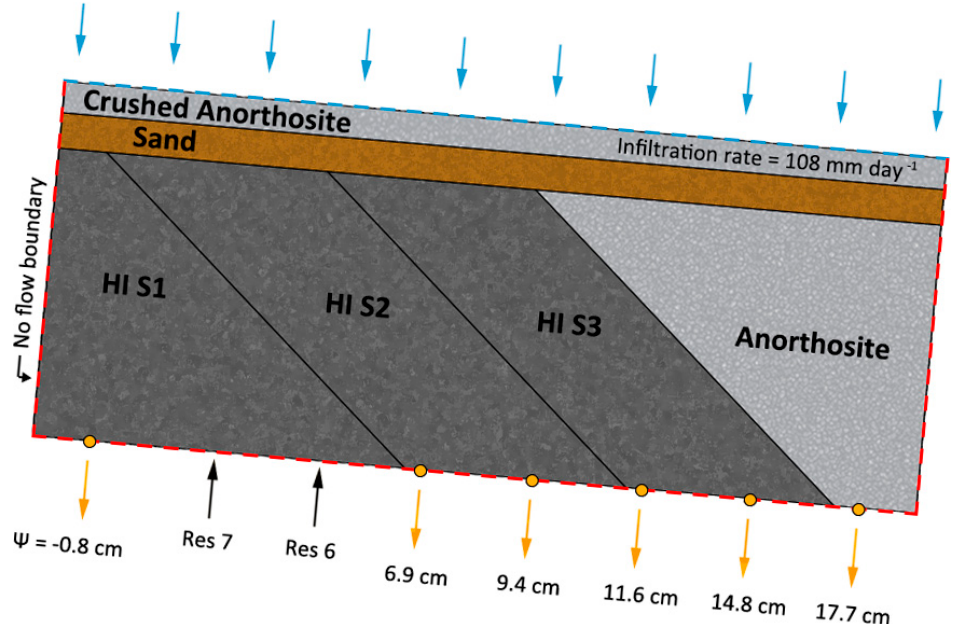
Figure 2. Conceptual model with the labeled boundary conditions and material property zones (where HI S1–HI S3 refer to 3 zones of hematite–ilmenite). Along the top surface (blue), an infiltration rate of 108 mm day − 1 is applied. The red dashed lines surrounding the other boundaries represent no flow boundaries. Yellow symbols with arrows represent the pressure head ( Ψ ) boundaries where the effluent was collected from each reservoir. Pressure head boundaries were calibrated to achieve the drainage rates observed from the laboratory experiment under steady-state flow conditions. Reservoirs 6 and 7 were treated as no flow boundaries in the numerical model, since no outflow was observed at either port; however, their locations are labeled here. Corresponding hydraulic heads from left to right: − 2.2, − 2.3, − 2.2, − 2.5, − 2.1, and − 2.0 cm.